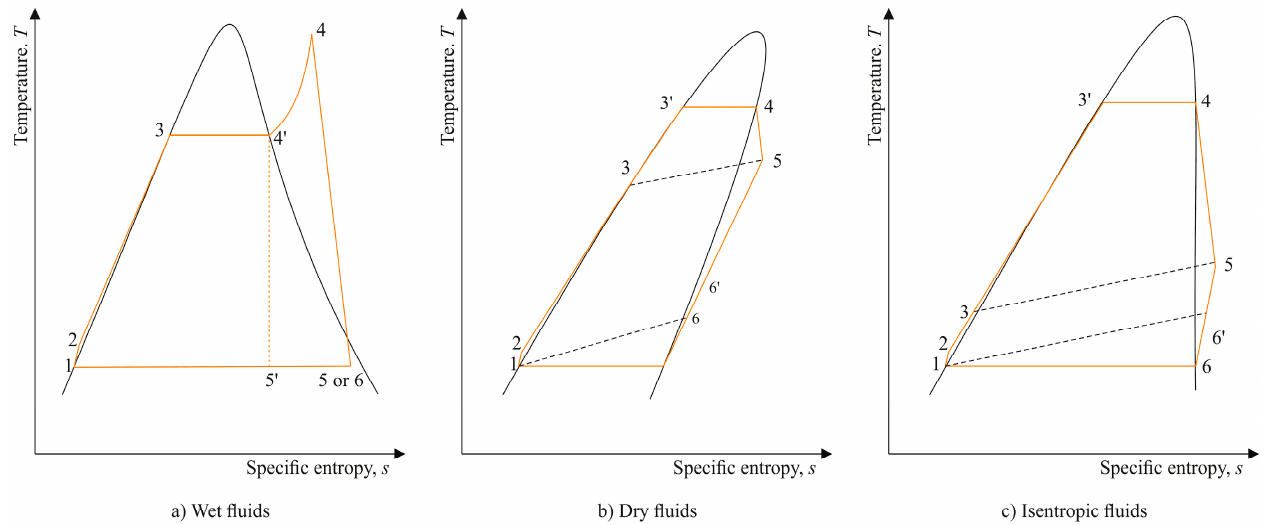
Figure 2. ( a ) Typical organic Rankine cycles for wet fluids. Cycle 1-2-3-4 (cid:48) -5 (cid:48) -1 is the saturated Rankine cycle leading to high erosion of turbine blades due to the high liquid content of the saturated mixture of the expanded fluid at the state 5 (cid:48) . As a remedy, superheating 4 (cid:48) -4 is used, and the superheating wet fluid cycle 1-2-3-4-5-1- is generally used. Both these cycles usually do not use a regenerator. ( b ) Typical saturated organic Rankine of dry fluids. After expansion in the turbine, the fluid is in the high temperature superheating state 5. Regeneration 5–6 is used to exploit this energy and to increase the cycle efficiency by preheating the fluid exiting the pump in the process 2–3. ( c ) Typical saturated organic Rankine of isentropic fluids. Regeneration is possible as in the case of dry fluids [52]. In Equation (1), C p is the specific heat of the fluid at constant pressure; T vap is the evap- oration temperature of the fluid; T r is the reduced evaporation temperature ( T r = T vap / T cr